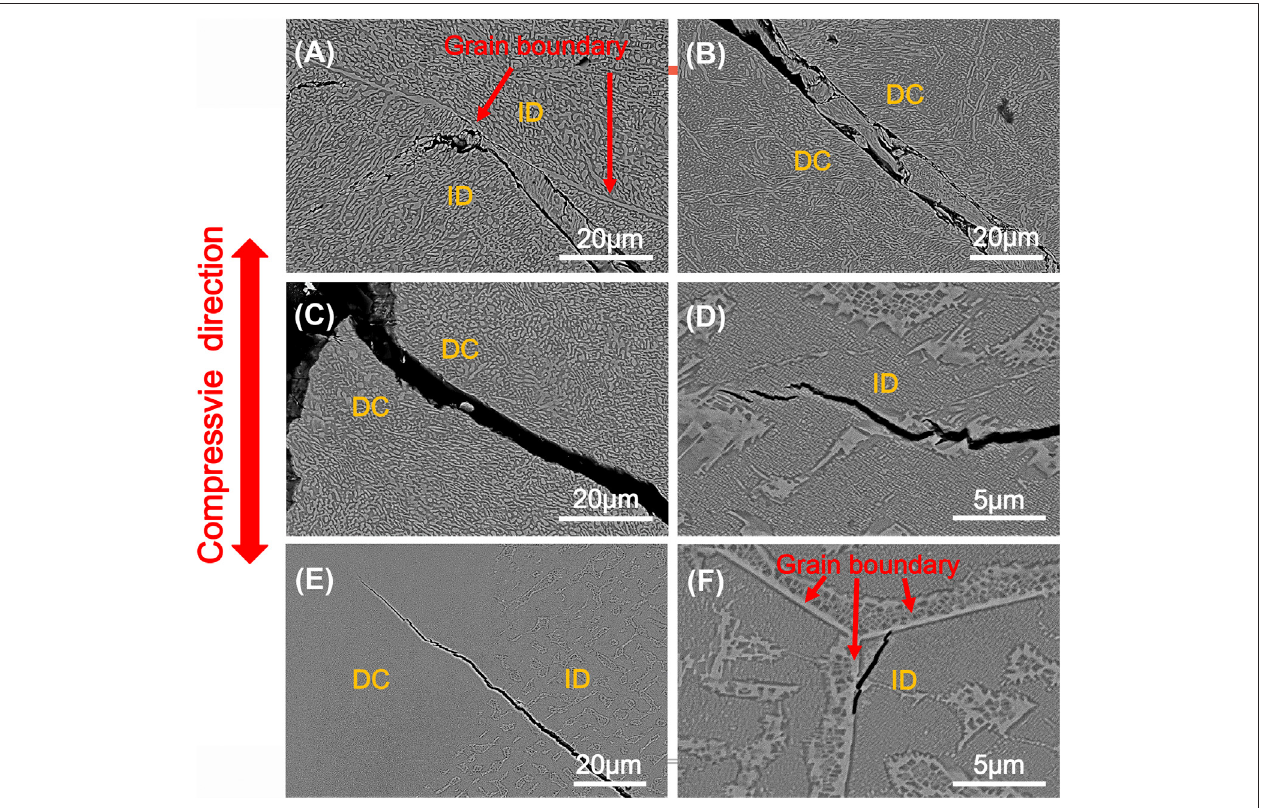
FIGURE3| Back-scatteredelectionimagesofcracksafterfractureinthecompressivetestatdifferentprocessingtemperatures (A – C) 950 ° C, (D – F) 1,200 ° C(Zhao et al., 2020a). (Reprinted from Journal of Alloys and Compounds, Vol 820, Zhao et al., Effect of strong magnetic fi eld on the microstructure and mechanical-magnetic properties of AlCoCrFeNi high-entropy alloy, Pages No.5, Copyright (2020), with permission from Elsevier).